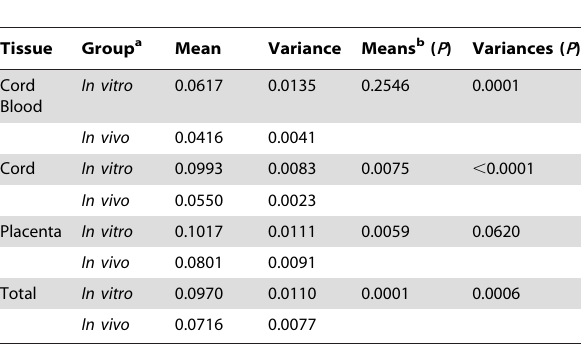
Table 1. Intra- and inter-individual variation in DNA methylation at the IGF2/H19 DMR.